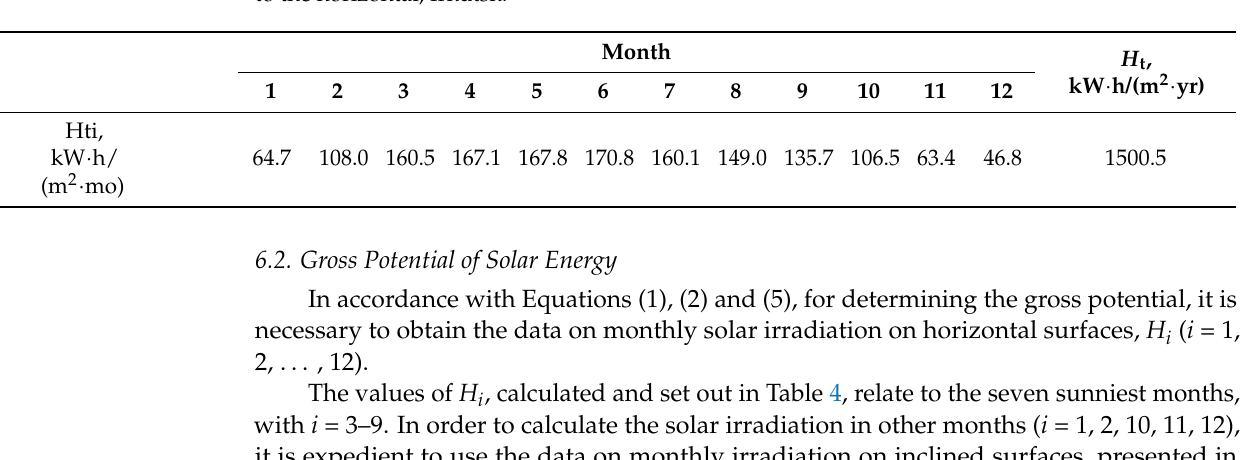
Table 5. Total monthly irradiation, H t i , and yearly irradiation, H t , on surfaces tilted at an angle of 45 ◦ to the horizontal,